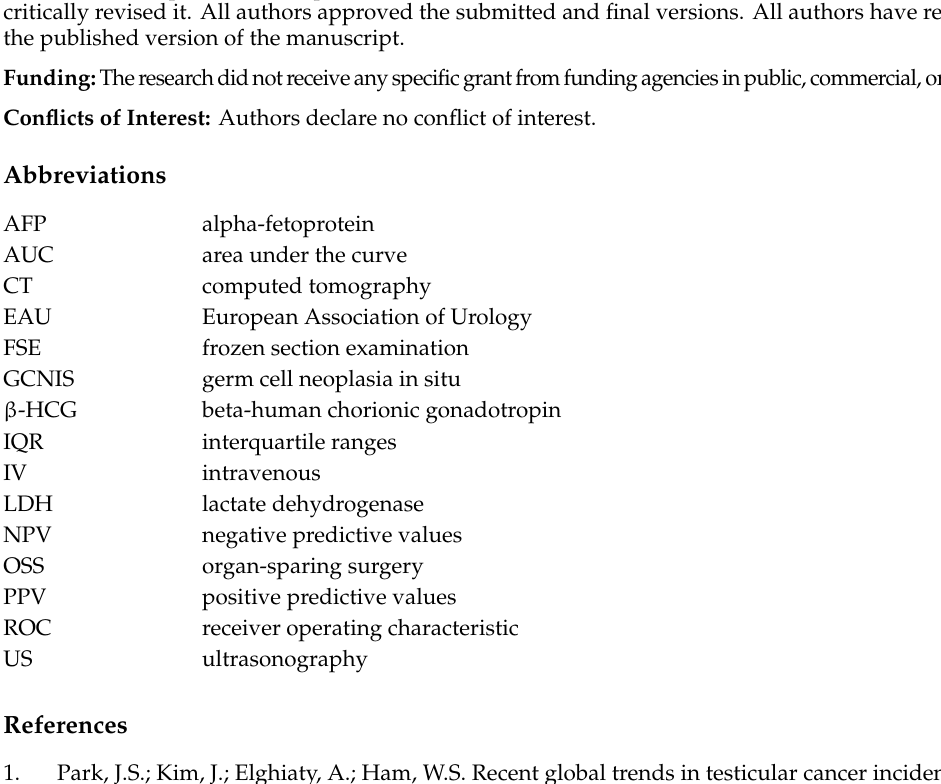
Figure S1: Percentage of malignant and benign tumors from organ-sparing surgery (OSS) approaches (Medical University of Innsbruck) over the past 15 years, Table S1: Hormonal profiles of 60 patients finally treated with OSS. Author Contributions: N.S. and G.T. and W.H. conceived and designed research. N.S. and G.T. performed the patient record reviews. K.B. was responsible for statistical analysis. N.S., G.T., M.L., M.K. and R.P. analyzed and interpreted the data. N.S., G.T., R.P. and W.H. drafted the manuscript. F.A. contributed radiological imaging. W.H. and R.P. were responsible for supervision. All authors made substantial contributions to the manuscript draft and critically revised it. All authors approved the submitted and final versions. All authors have read and agreed to the published version of the